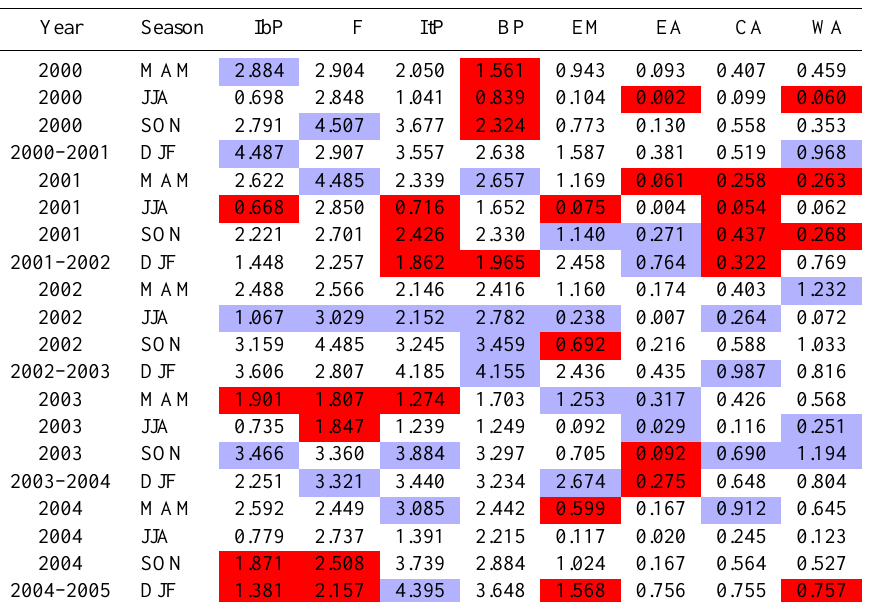
Table 1. Seasonal mean precipitation rates (mmday − 1 ) averaged for each of the target regions indicated in Fig. 1. For each season and region, the highest and the lowest values are highlighted in blue and red,